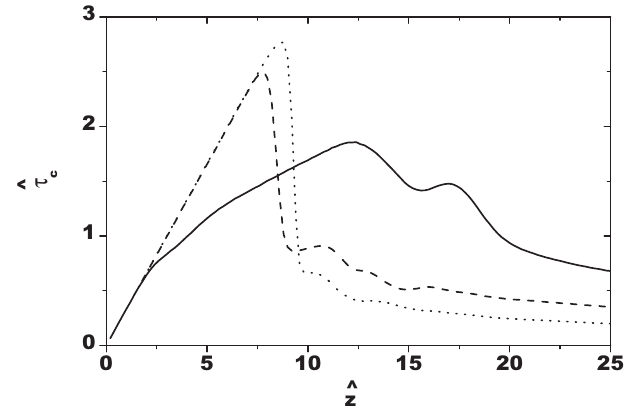
FIG. 9. Normalized coherence time of a SASE FEL as a function of normalized undulator length. Solid, dashed, and dotted lines correspond to the fundamental, 3rd, and 5th har- monic,